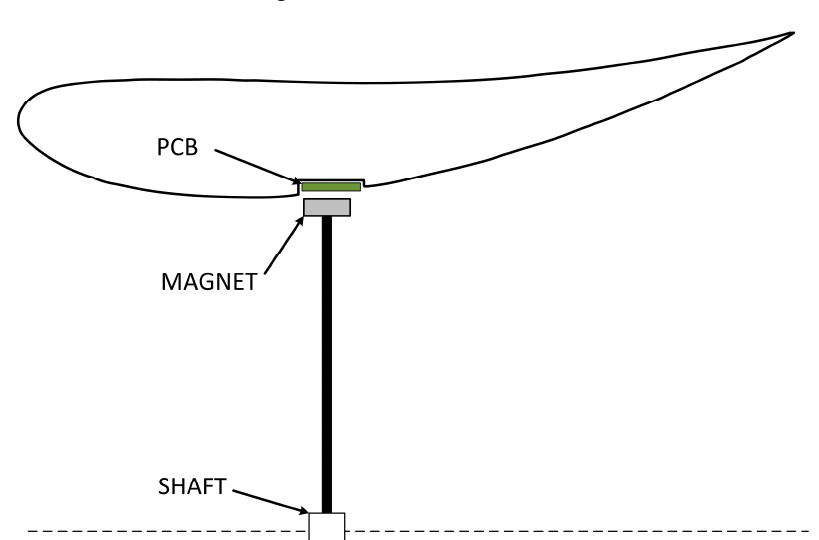
Figure 3. Render of the diffuser.